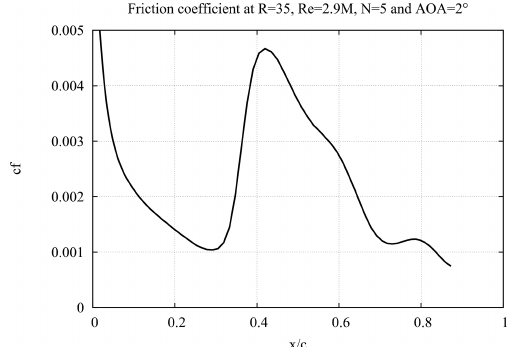
Figure 11. Location of transition from wall shear stress by CFD code FLOWer. N = 5 corresponds to a T.I. of 0.3%. The onset of transition may be located at x/c = 0 . 29, and the flow is fully turbu- lent at x/c = 0 . 42. The slope is at a maximum at x/c = 0 . 36 .